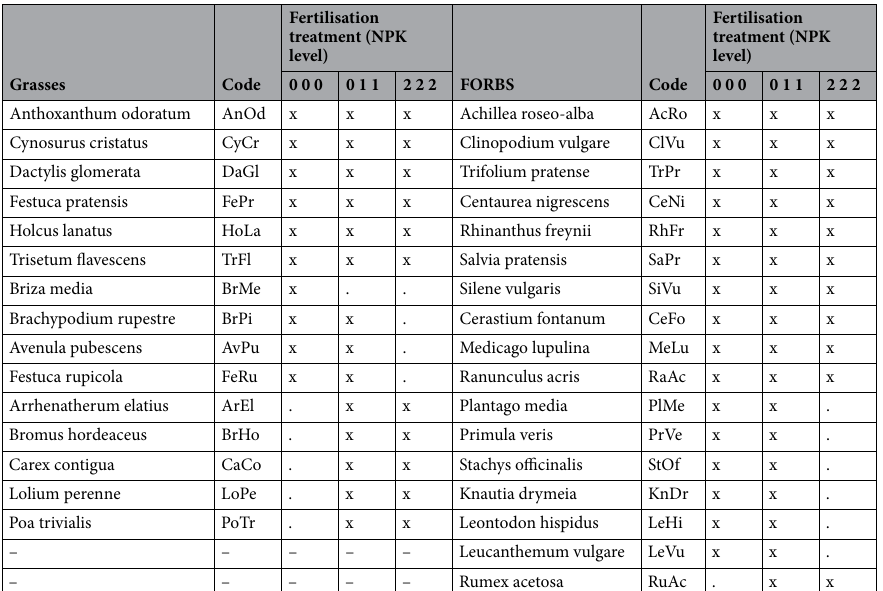
Table 1. Species studied for reproductive traits in a grassland fertilisation trial in the Italian eastern Alps. The graminoid species Carex contigua is included in the grass functional